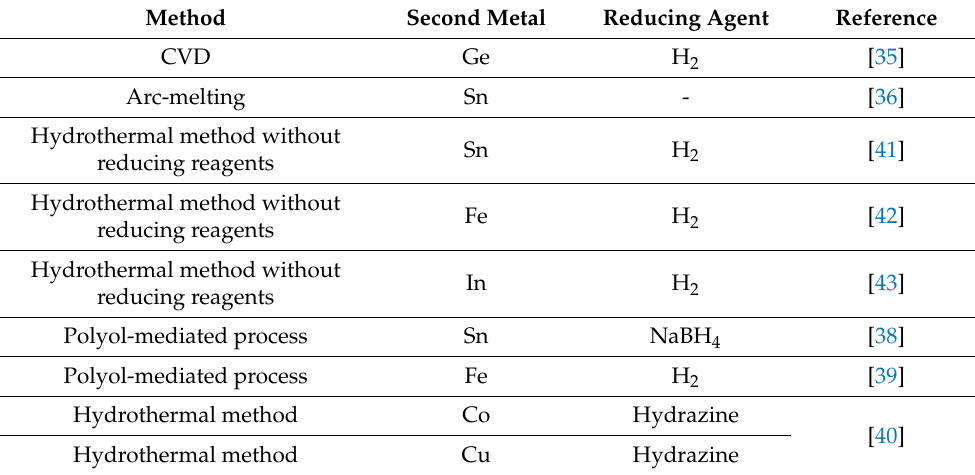
Table 1. Cont . Method Second